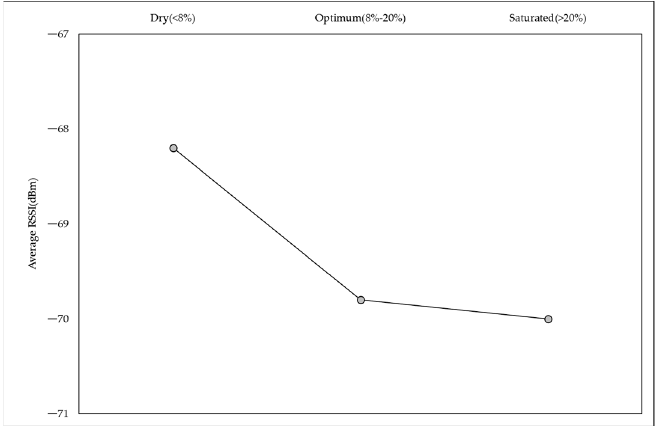
Figure 5. A plot of signal attenuation by moisture contents.